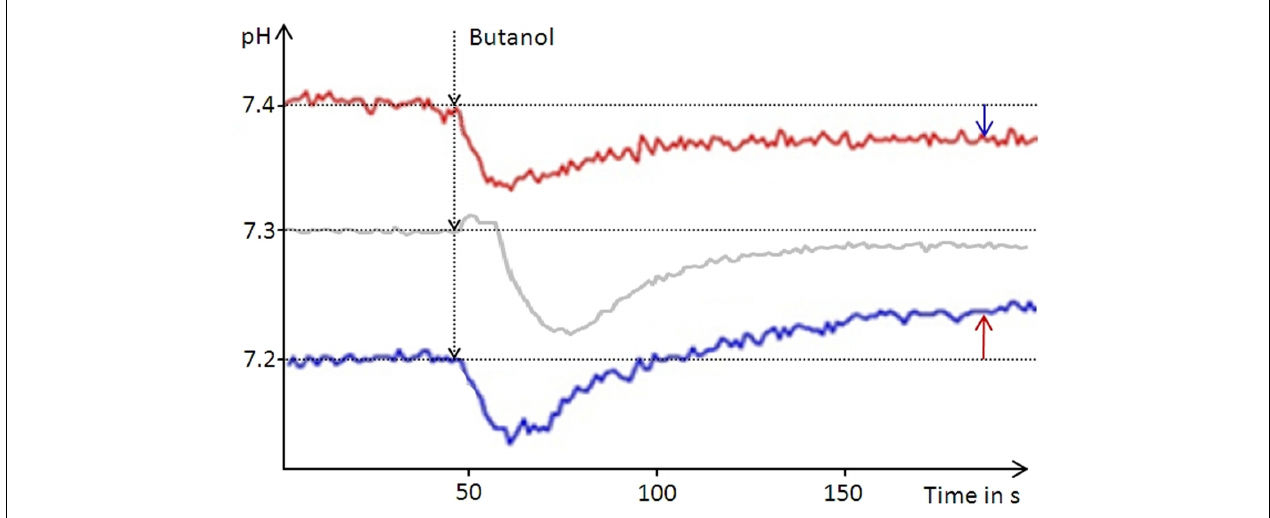
FIGURE 1 | Narrowing down the intracellular pH of D. shibae. The pH of an unbuffered cell suspension was constantly recorded during butanol treatment leading to leakage of the cells. Arrows indicate the direction of the pH change from the respective starting pH of the suspension (red graph 7.4, blue graph 7.2) toward the intracellular pH of 7.3. At the starting pH of 7.3 the pH change is very small and can vary between the experiments.